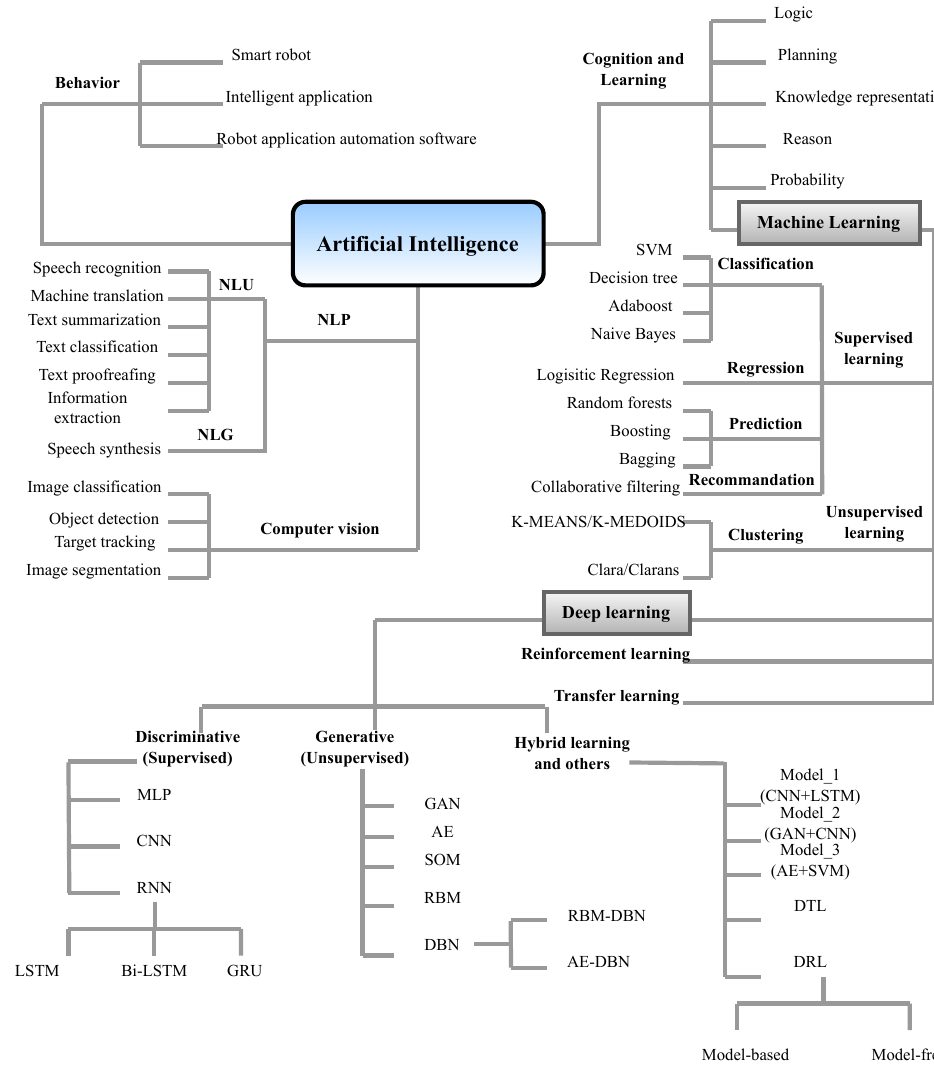
Figure 17. A taxonomy of AI, ML,